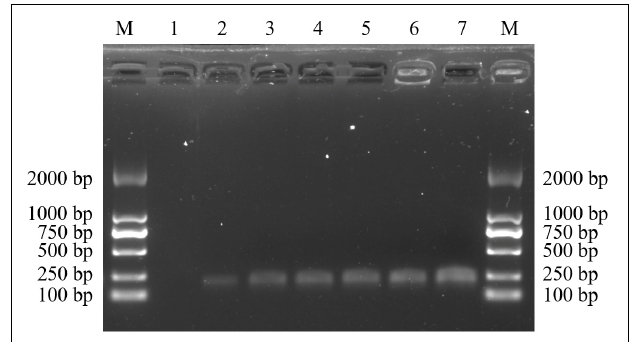
FIGURE 5 | Amplification profiles of the primer pair SHF/SHR in different D. officinale genome DNA concentrations. Lane M: Trans2K DNA Marker with lengths (bp); Lane 1–7: 0, 5, 10, 15, 20, 30, and 50 ng/ µ L of D. officinale DNA template concentration.